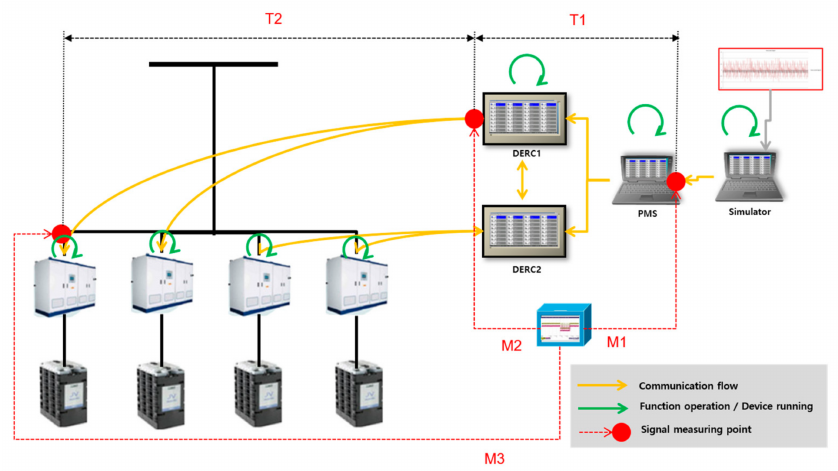
Figure 12. Time performance test